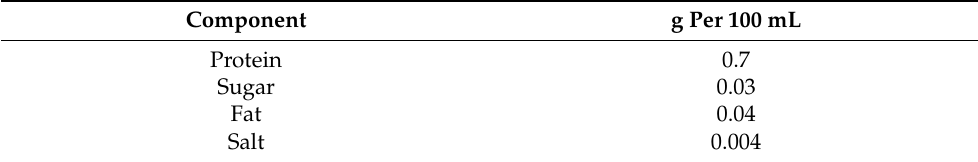
Table 2. Whey protein solution composition used as feed